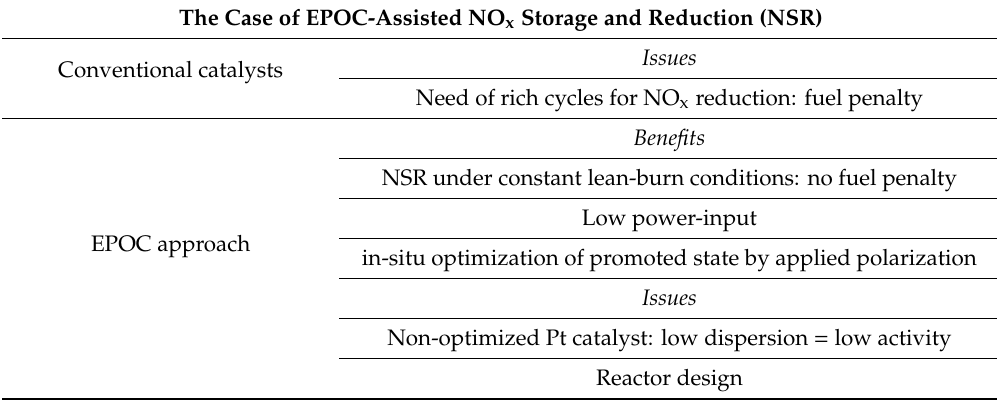
Table 2. Main issues and benefits of the EPOC-assisted NOx storage and